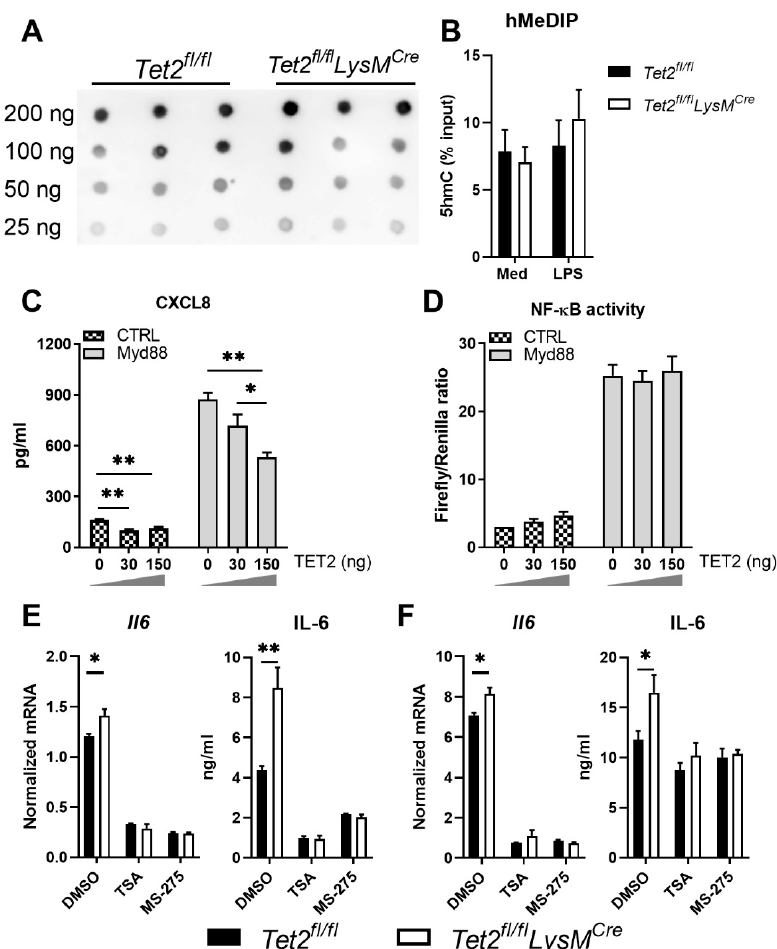
Figure 3. HDACs are involved in TET2-mediated regulation of IL-6 production. ( A ) DNA methylation levels in naive bone marrow-derived macrophages (BMDMs) from Tet2 fl/fl LysM Cre and control mice measured by dot blots; ( B ) 5-hydroxymethylcytosine (5hmC) levels measured by hydroxymethylated DNA immunoprecipitation (5hMeDIP) at the Il6 promoter in peritoneal macrophages (PMs) from Tet2 fl/fl LysM Cre (open bars) and control mice (black bars) stimulated with LPS or medium control for 12 h; ( C , D ) CXCL8 production by and NF- κ B activity in HEK293T cells co-transfected with MyD88 and increasing amounts of TET2 expression vector (0, 30 or 150 ng) 24 h earlier; ( E , F ) IL-6 protein production by BMDMs ( E ) and PMs ( F ) from Tet2 fl/fl LysM Cre and control mice after stimulation with LPS (100 ng/mL) for 12 h following the pretreatment of 100 nM TSA or 4 µ M MS-275. n = 3 for ( A – D ), n = 6 for ( E , F ). Data is shown as bar graphs with mean ± SEM. p -values were calculated using Mann–Whitney test. * p < 0.05, ** p < 0.01.